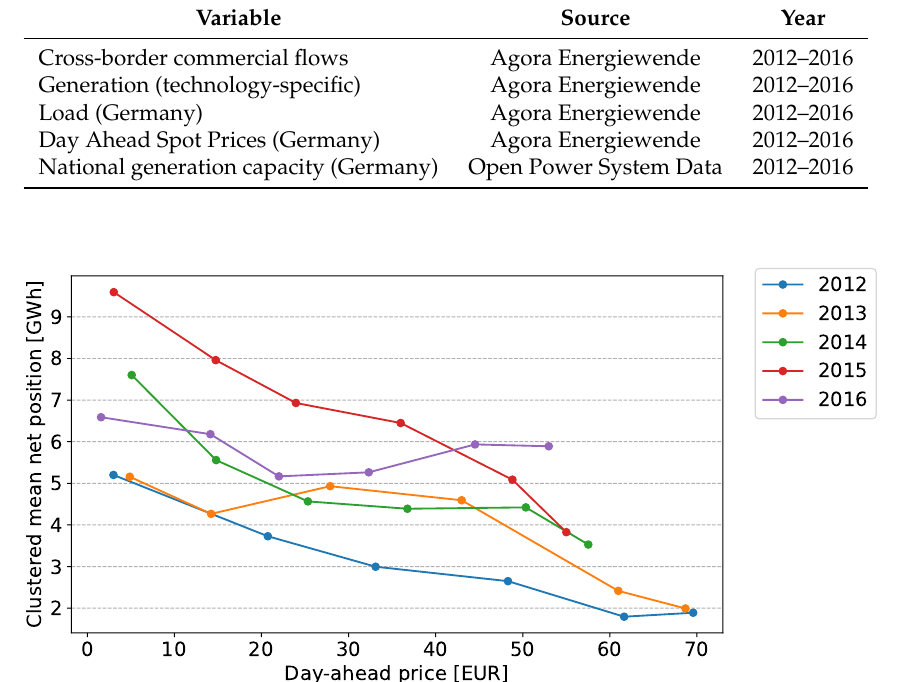
Figure 4. Mean net commercial trade balance, source: own illustration, data: [2].